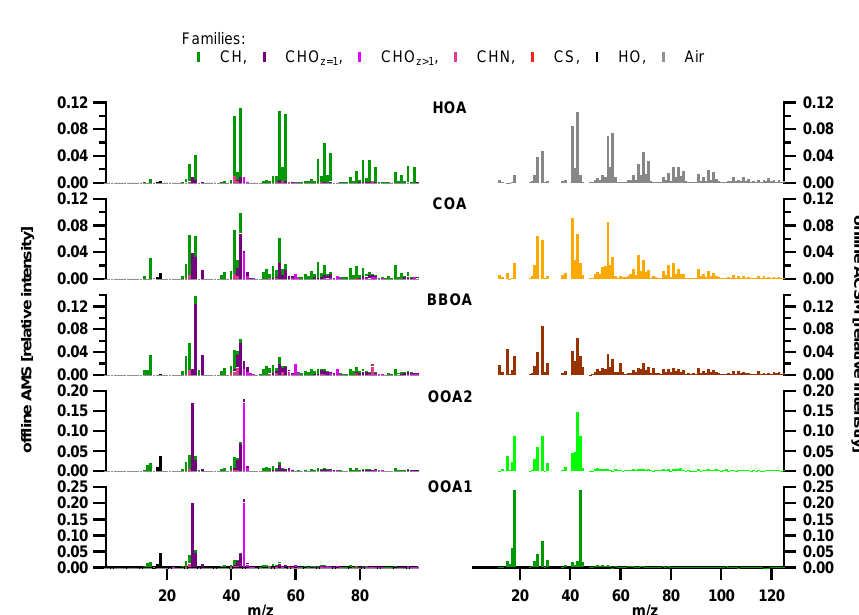
Figure 9. Comparison of overall factor profiles obtained for the chosen solutions both from the offline (left, for HOA and COA, spectra from Mohr et al. (2012) were used as reference) and the retrieved factor profiles from the online source apportionment